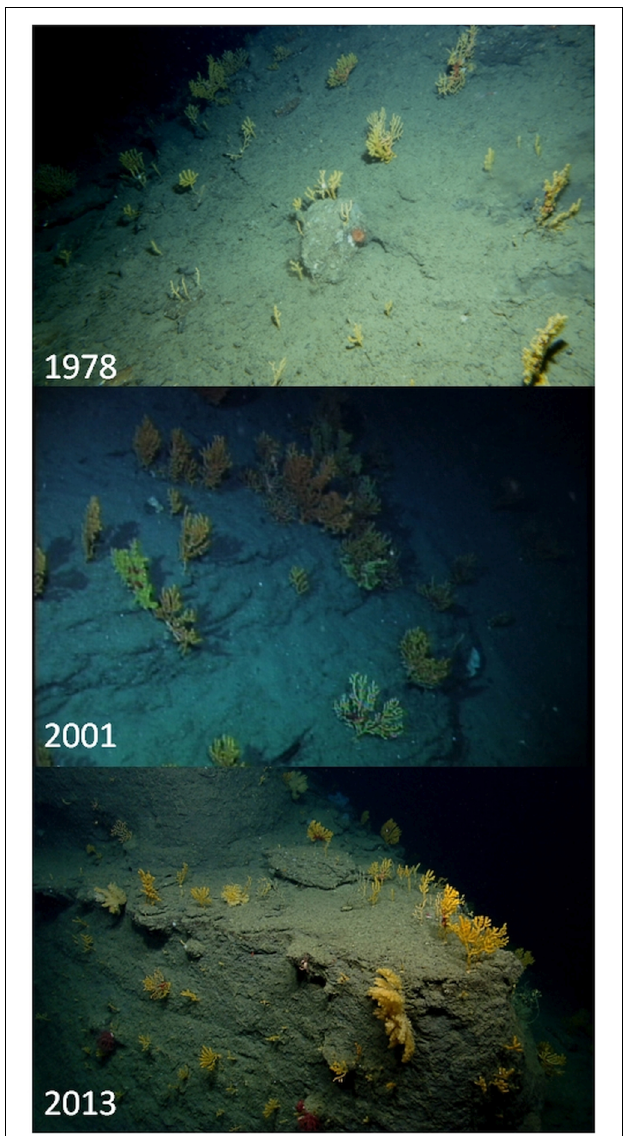
FIGURE 5 | Exemplars of imagery from submersible dives in the same area of Oceanographer Canyon at ca. 1,100 m depth in 1978, 1980, 2001, 2005, and 2013 facilitated an examination of community structure and found high similarity in community composition over time (Kilgour et al., 2016), demonstrating a high degree of stability of undisturbed habitats. (Images from 1978 to 2001 from DSV Alvin dives; 2013 from NOAA Okeanos Program